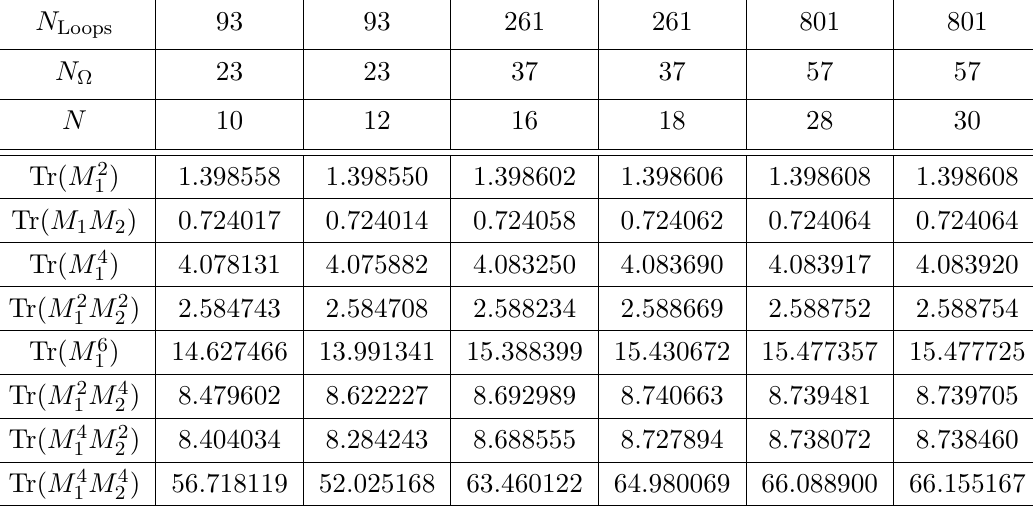
Table 8. Results for g 3 = 0 . 05 , k = 0 . 5 for l = 5 , 6 , 7 and increasing N . Note that the length of the last loop is > 7 .